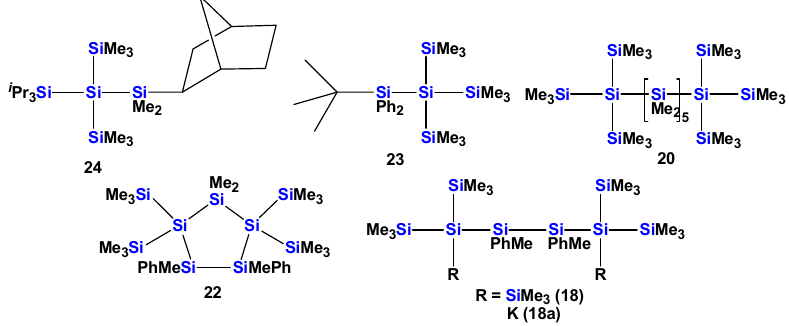
Figure 4. Some new compounds prepared in this study either as starting materials or as subjects for UV-spectroscopic